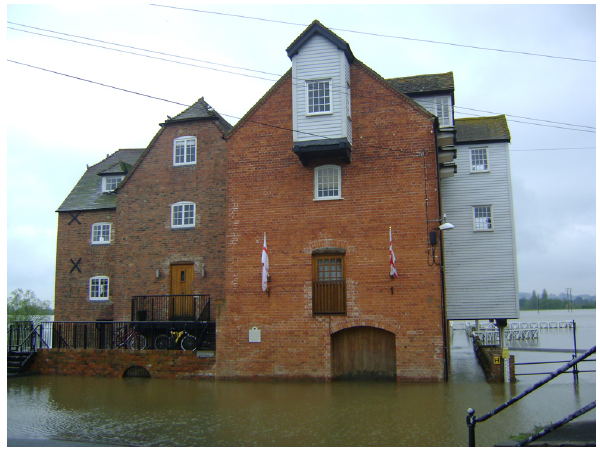
Fig. 1. Recent flooding at Tewkesbury (Stephenson,